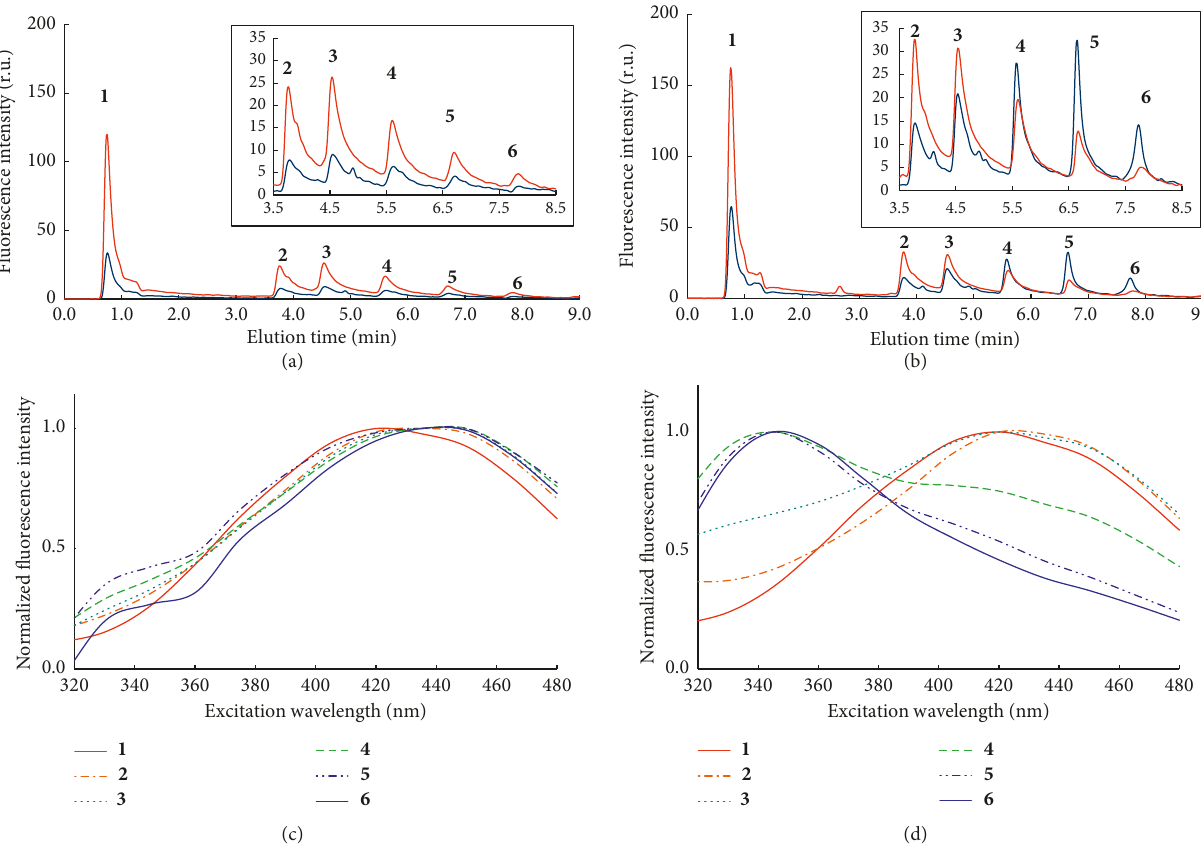
Figure 5: RP-HPLC chromatograms of CDOM from the Verhnee (a) and Onego (b) lakes with online fluorescence detection at exci- tation/emission wavelength pairs 270/450nm (red lines) and 270/350 nm (blue lines) for detection of humic-like and protein-like fluo- rescence, respectively. Inset zoom shows the zone of chromatograms from 3.5 to 8.5min. Normalized emission spectra of the peaks #1–6 of fractionated CDOM from the Verhnee (c) and Onego (d) lakes. The CDOM from the Vodoprovodnoe lake demonstrated similar chromatograms and emission spectra with that of the Verhnee